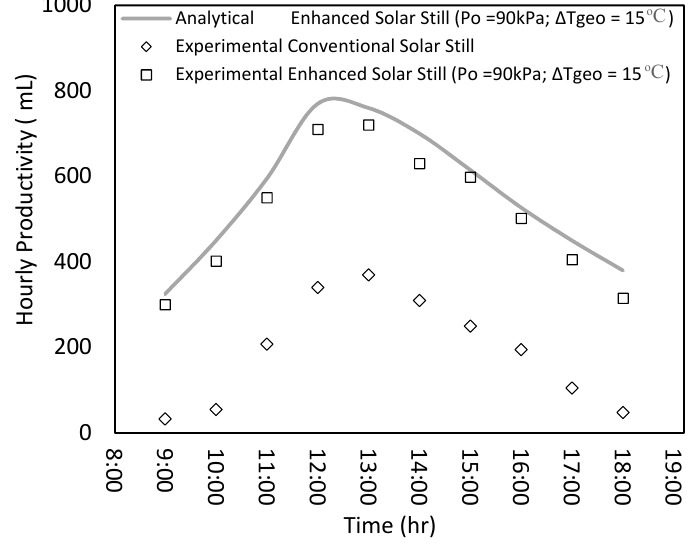
Figure 4. Comparison of analytical and experimental results.